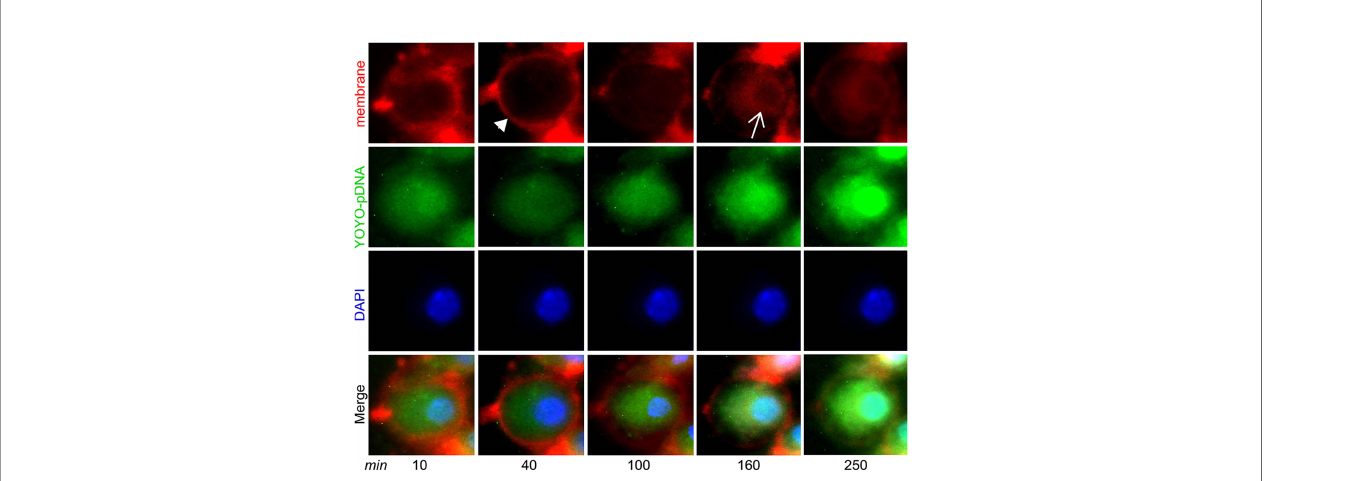
FIGURE 3 | YOYO-IL-4pDNA/NPs cross the cell and nuclear membranes to enter the nucleus. Live cell imaging was used to assess cytoplasmic transportation and the nuclear entrance of YOYO-IL-4pDNA-NPs. The cultures were treated with YOYO-IL-4pDNA-NPs (green) and the cell membranes were labeled with CellBrite Fix555 (red) . The nuclei were labeled with DAPI (blue) . The images were initially taken at 10 minutes and automatically scanned every 30 minutes under live cell fl uorescence microscopy. YOYO-IL-4pDNA were seen to cross the cell membrane (red, arrow head) at 30 minutes. Red CellBrite Fix555 labeled the nuclear envelop (red, arrow) as seen at 160 minutes, showing YOYO-IL-4pDNA entered the nucleus. After 250 minutes, YOYO-IL-4pDNA was highly accumulated within the nucleus (bright green) , suggesting the cytoplasmic transportation of YOYO-IL-4pDNA into the